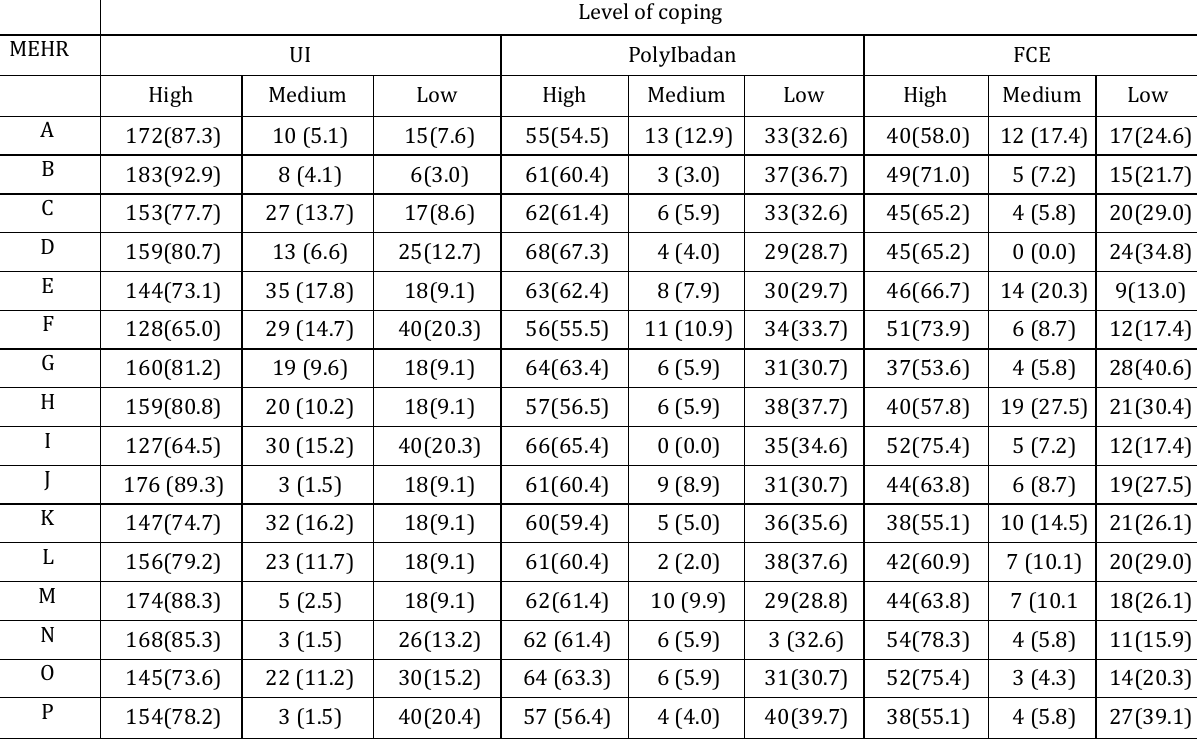
Table 9. Level of students’ coping ability with sanitary hazards in hostels (source: Authors’ fieldwork data analysis,